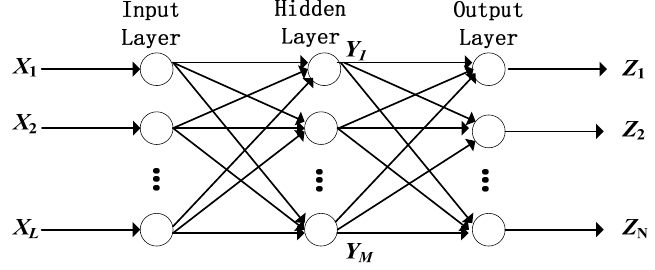
Figure 5. Diagram of the BP neural networks.